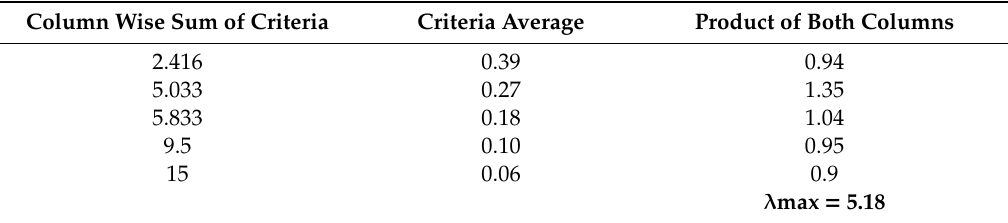
Table 6. Calculation of consistency index